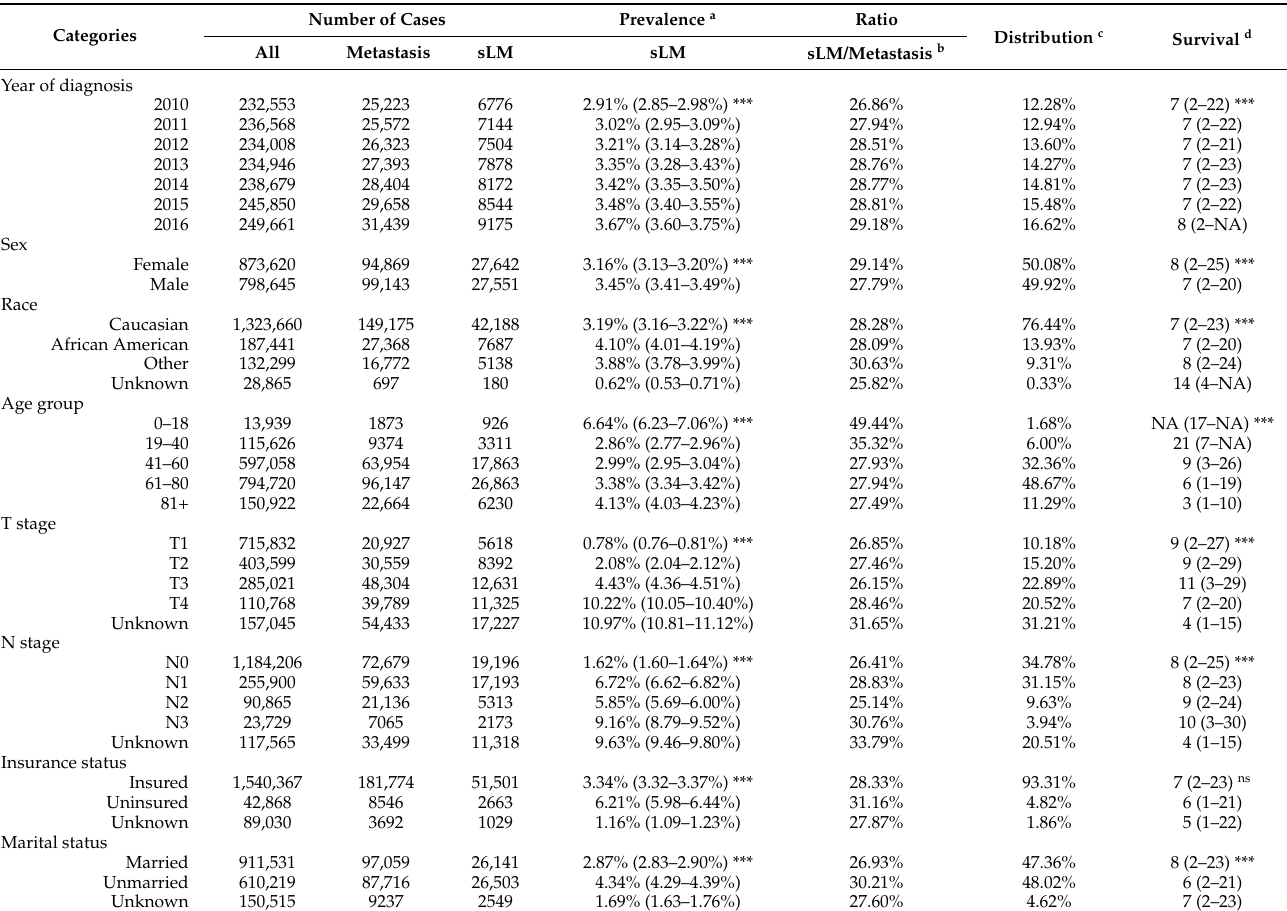
Table 2. Number of all cases, metastatic cases and cases with synchronous lung metastasis and their corresponding prevalence, distribution, and median survival with interquartile range by clinicode- mographic